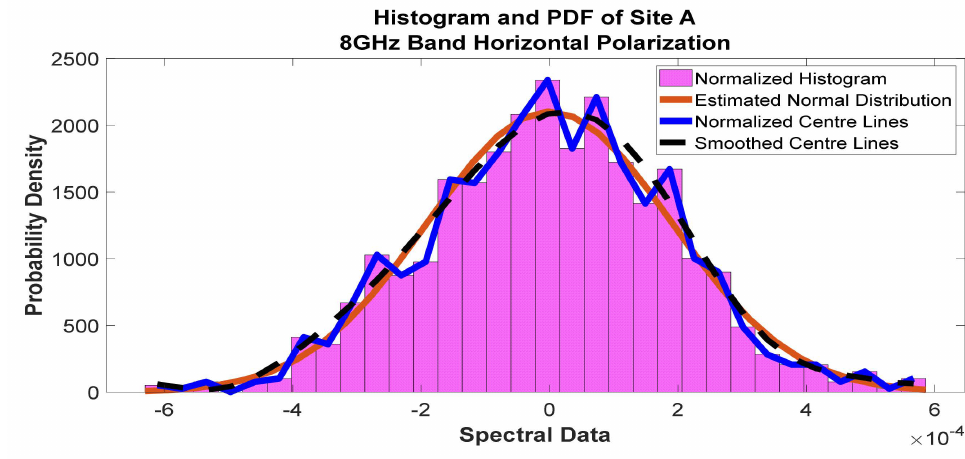
Figure 27. Histogram and PDF of the frequency scan for site A at 8 GHz horizontal polarization.